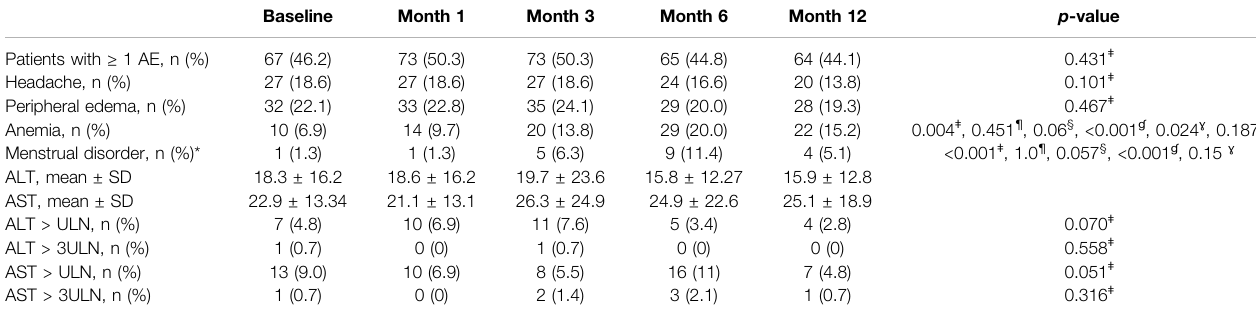
TABLE 2 | Adverse events.